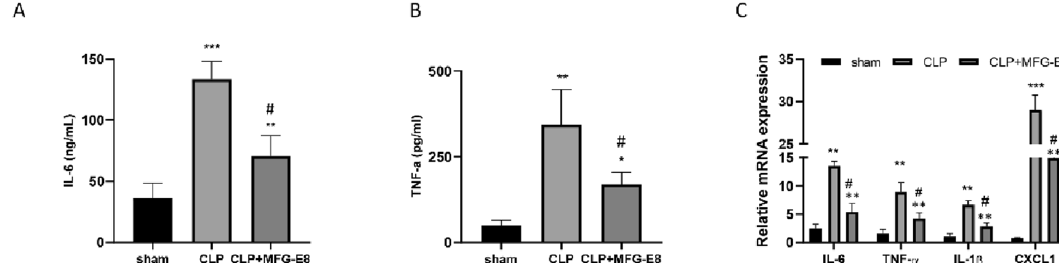
Figure 4. MFG-E8 administration reduces levels of inflammatory factors in the serum and liver tissues of CLP- induced septic mice. ( A,B ) Serum levels of inflammatory factors (IL-6, TNF-α) in septic mice at 24 h after CLP. ( C ) Relative mRNA expression levels of inflammatory factors (IL-6, TNF-α, IL-1β, and CXCL1) in the liver of septic mice at 24 h after CLP after normalization with GAPDH mRNA levels as determined by qRT-PCR. n = 6, mean ± SEM. (*p < 0.05 versus sham group; #, *p < 0.05 versus CLP group; *p < 0.05, **p < 0.01, ***p < 0.001).